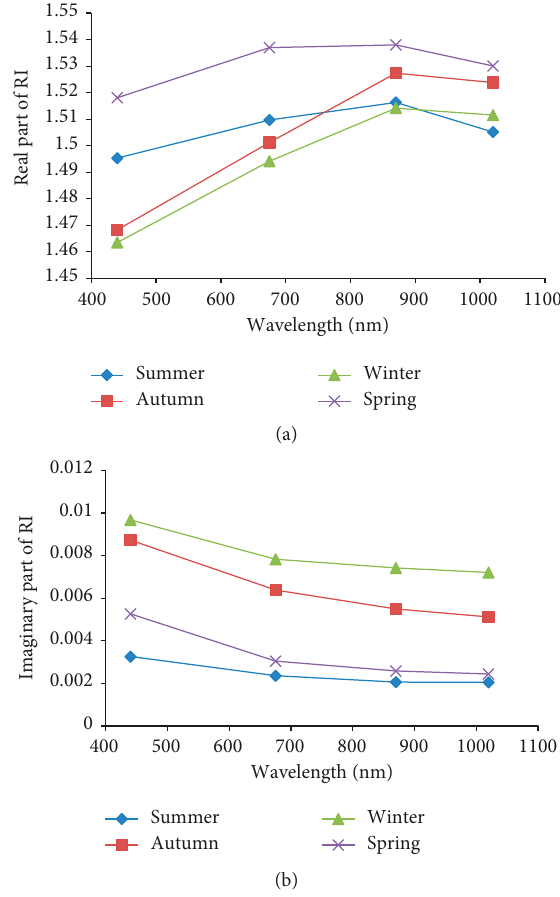
Figure 8: Seasonal variations in (a) real part and (b) imaginary part of the RI (refractive index) over Karachi during September 2006–August 2014.